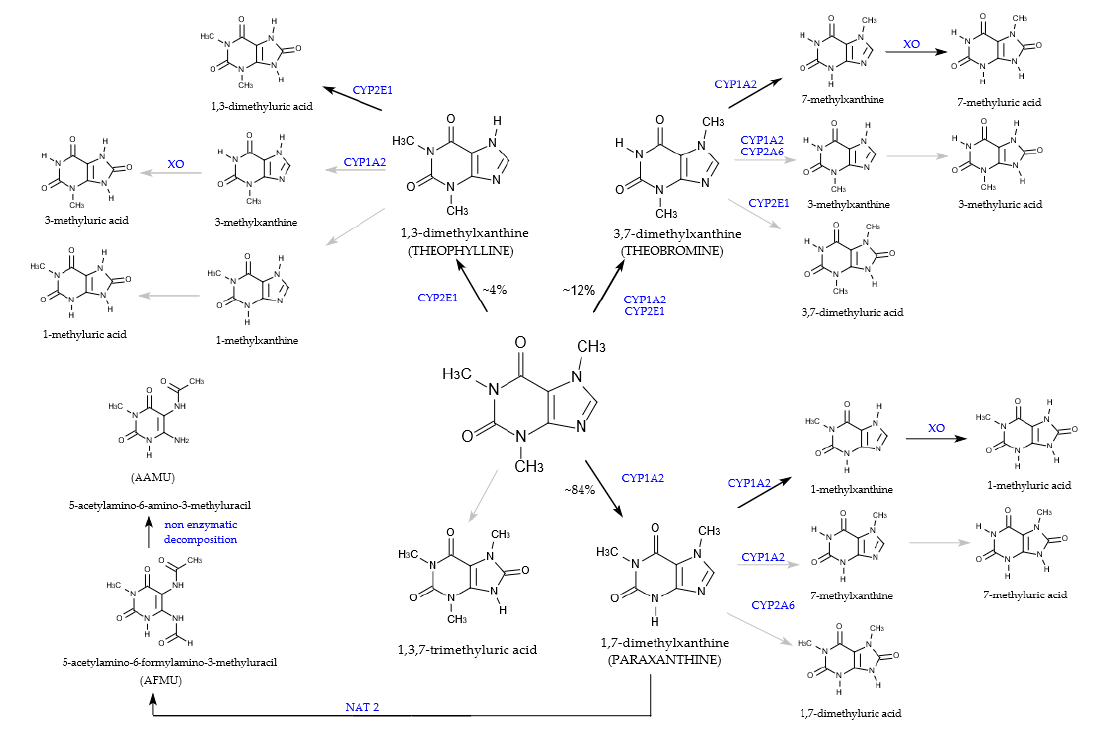
Figure 3. Metabolic pathways of caffeine and metabolites in humans. Grey arrows indicate lower production of the metabolite. Adapted from [132]. XO: xanthine oxidase, NAT 2: N-acetyltransferase 2.